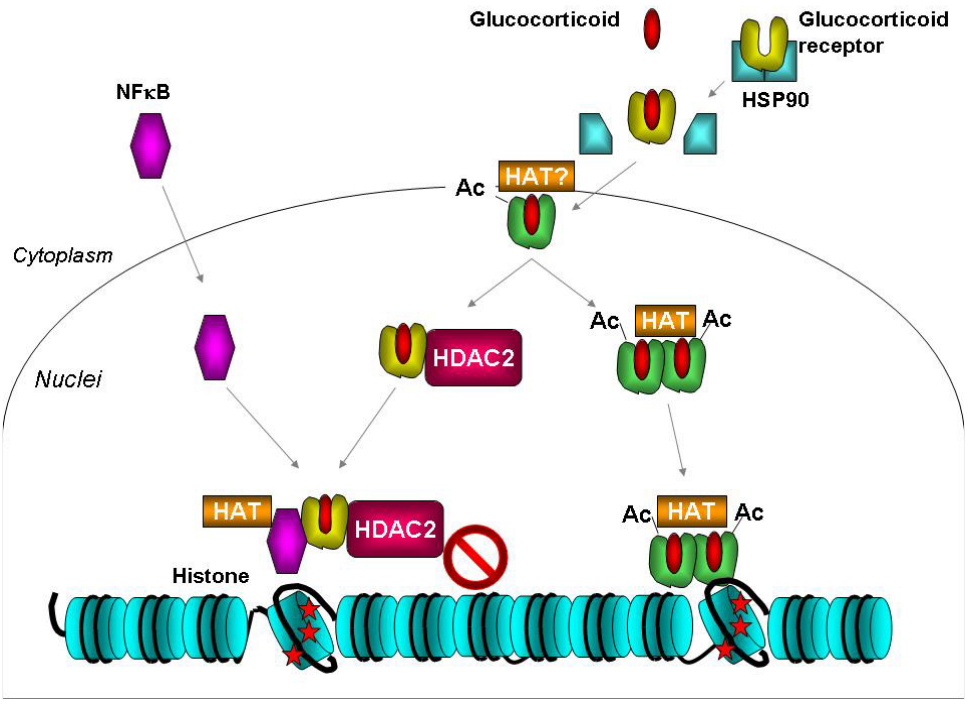
FIGURE 4. GR acetylation. After ligand binding, GR is acetylated and dimerized. The dimer binds GRE and induces anti- inflammatory factors where this binding likely causes side effects. On the other hand, HDAC2 is recruited to the acetylated GR and deacetylates it to allow binding to NF- κ B, resulting in repression of NF- κ B–dependent gene